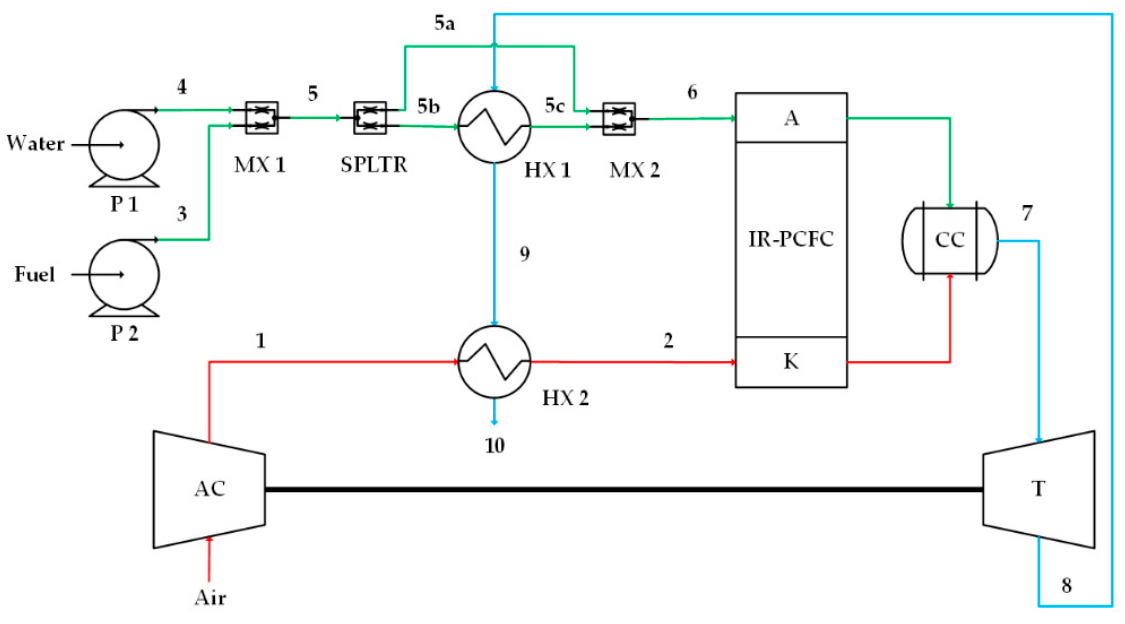
Figure 1. Case 1, high-quality heat from turbine flows into the anode preheater (HX1). A, AC, K, HX, MX, P, SPLTR, and T stand for the anode, air compressor, cathode, combustion chamber, heat exchanger, mixer, pump, splitter, and turbine, respectively. Numbers 1 and 2 on the red lines indicate cathode flow, numbers 3, 4, 5, 5a, 5b, 5c and 6 on the green lines indicate anode flow, and numbers 7, 8, 9 and 10 on the blue lines indicate combustion flow.